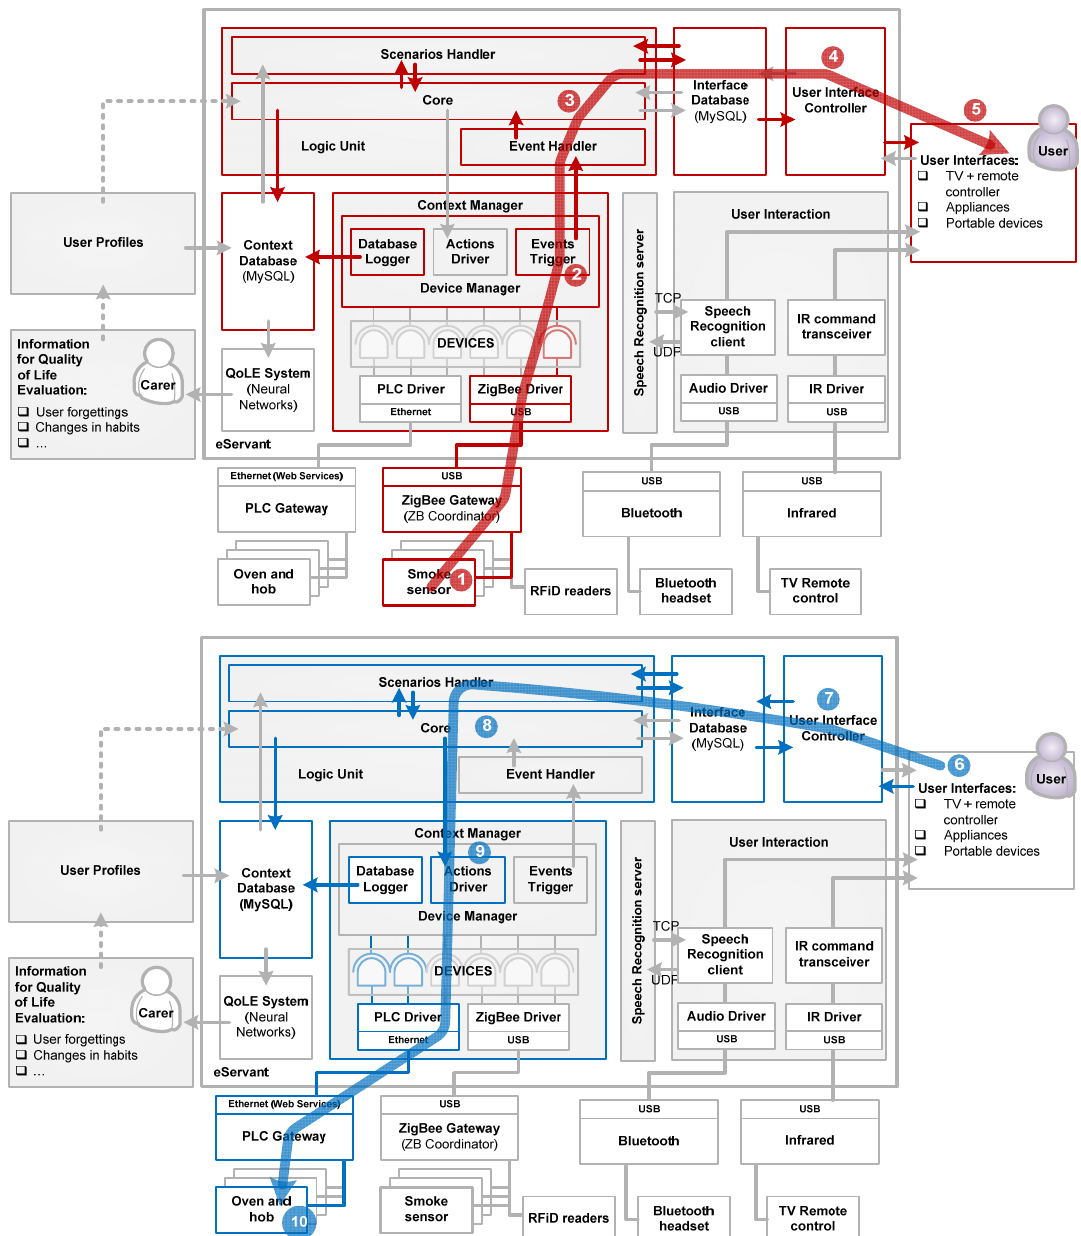
Figure 7. Use case: smoke sensors notify the system that there is smoke in the kitchen, oven and hob are on but nobody is in the